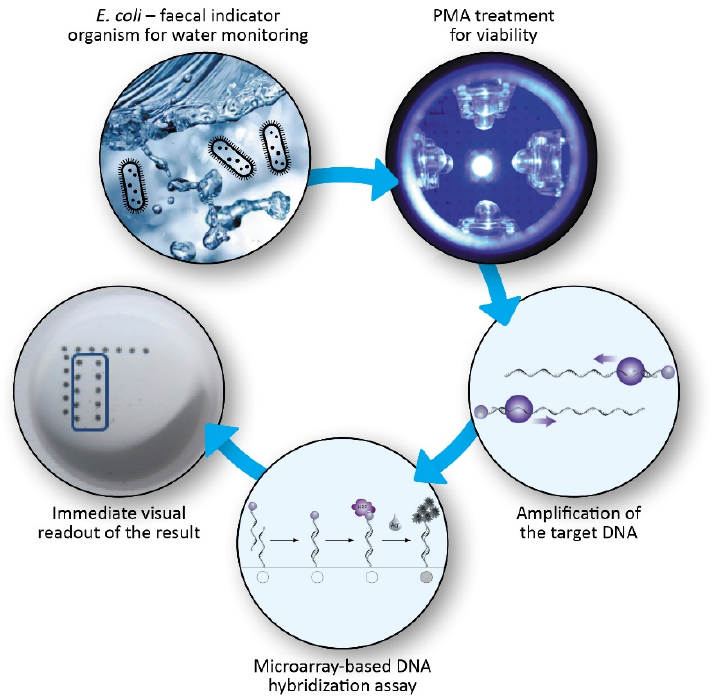
Figure 1. Scheme, illustrating individual steps of the v-PCR based detection